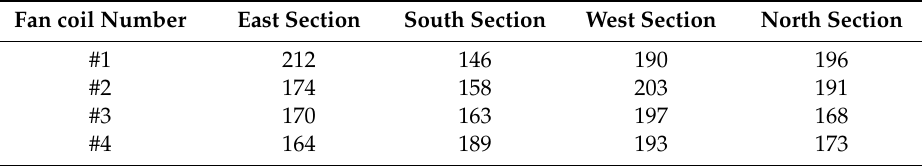
Table 2. Air flow rate, Q , m 3 / h, through the supply openings of each fan